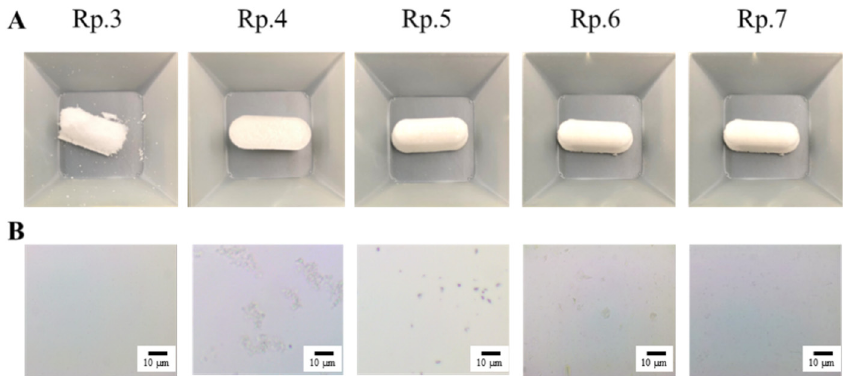
Figure 2. Image of the IRB-NP tablets shown in Table 1. ( A ) Photograph of IRB tablets (Rp. 3–7); ( B ) microscopic image in redispersed IRB tablet (Rp.3–7). IRB tablets were suspended in purified water. Bars show 10 µm. The form of the tablet based on IRB-NP suspensions was maintained by the addition of D-mannitol, PVP, and gum arabic (Rp.7), and the IRB particles in the redispersion were nanoparticles.